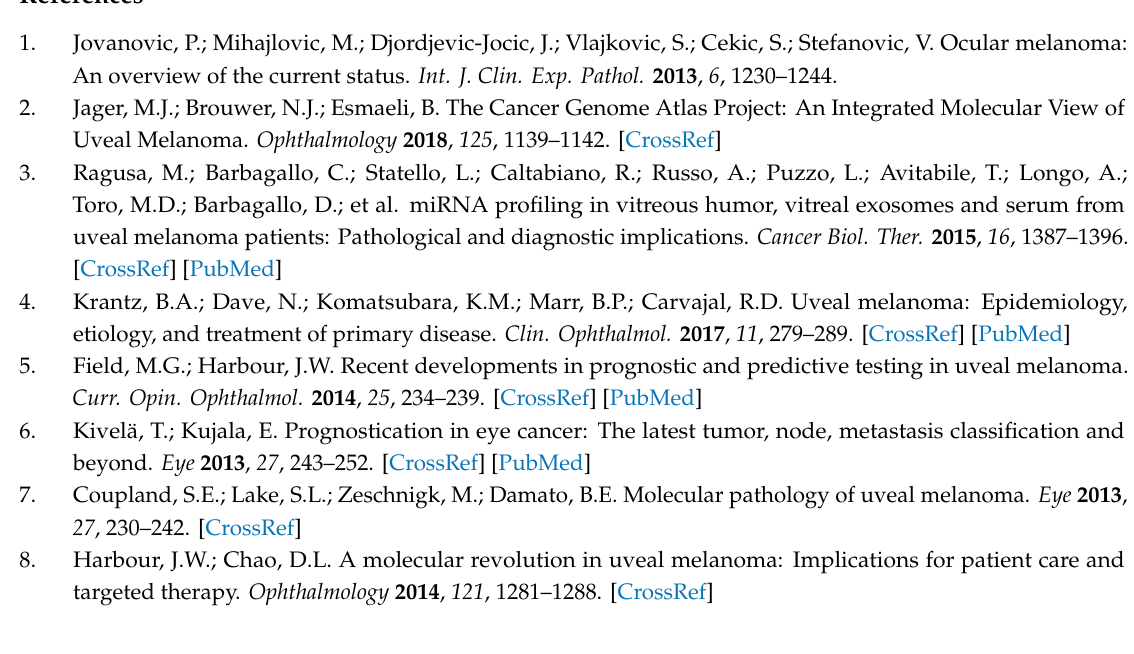
s1 Figure S1: Isolation and maintenance of normal choroidal melanocytes (NCM). Figure S2: Phenotypical characterization of cultured human NCM. Figure S3: Nanoparticle tracking analysis of EVs derived from UM and NMC cells. Figure S4: Transmission electron microscope images displayed represented data of EVs derived from UM and NCM cells. Figure S5: Purification of PKH67-labelled EVs. Figure S6: UM-EVs did not a ff ect the viability of Fibro-BKO cells. Figure S7: Complete Western-blot PVDF membrane. Figure S8: Measuring size and concentration of EVs derived from NCM (blue), MEL270 UM-EVs (red) and OMM2.5 UM-EVs (black). Figure S9: Western blot analysis of common EV marker CD63 (A) and control beta actin (B). Figure S10: Immunoelectron microscopy images of EVs isolated from MP41 (A) and MEL270 (B) cell lines. Table S1: Cells used in this study. Table S2: Di ff erentially Expressed Proteins between NCM-EVs and primary UM-EVs ( p < 0.05). Table S3: Di ff erentially Expressed Proteins between primary MEL270 UM-EVs and metastatic OMM2.5 UM-EVs ( p < 0.05). Table S4A: DAVID analysis of upregulated proteins between NCM-EVs and primary UM-EVs. Table S4B: DAVID analysis of downregulated proteins between NCM-EVs and primary UM-EVs. Table S5A: DAVID analysis of upregulated proteins between primary MEL270 UM-EVs and metastatic OMM2.5 UM-EVs. Table S5B: DAVID analysis of downregulated proteins between primary MEL270 UM-EVs and metastatic OMM2.5 UM-EVs. Table S5C: DAVID analysis of upregulated proteins between primary MEL270 UM-EVs and metastatic OMM2.5 UM-EVs. Lists of proteins clustered into the DAVID subcategories referred to in Figure 8. Table S5D: DAVID analysis of downregulated proteins between primary MEL270 UM-EVs and metastatic OMM2.5 UM-EVs. Lists of proteins clustered into the DAVID subcategories referred to in Figure